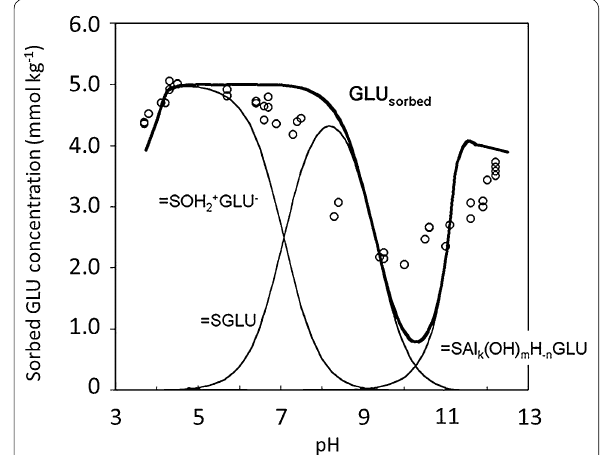
Fig. 3 pH sorption edge of d -gluconic acid and sorption model- ling. Initial d -gluconic acid concentration in the aqueous